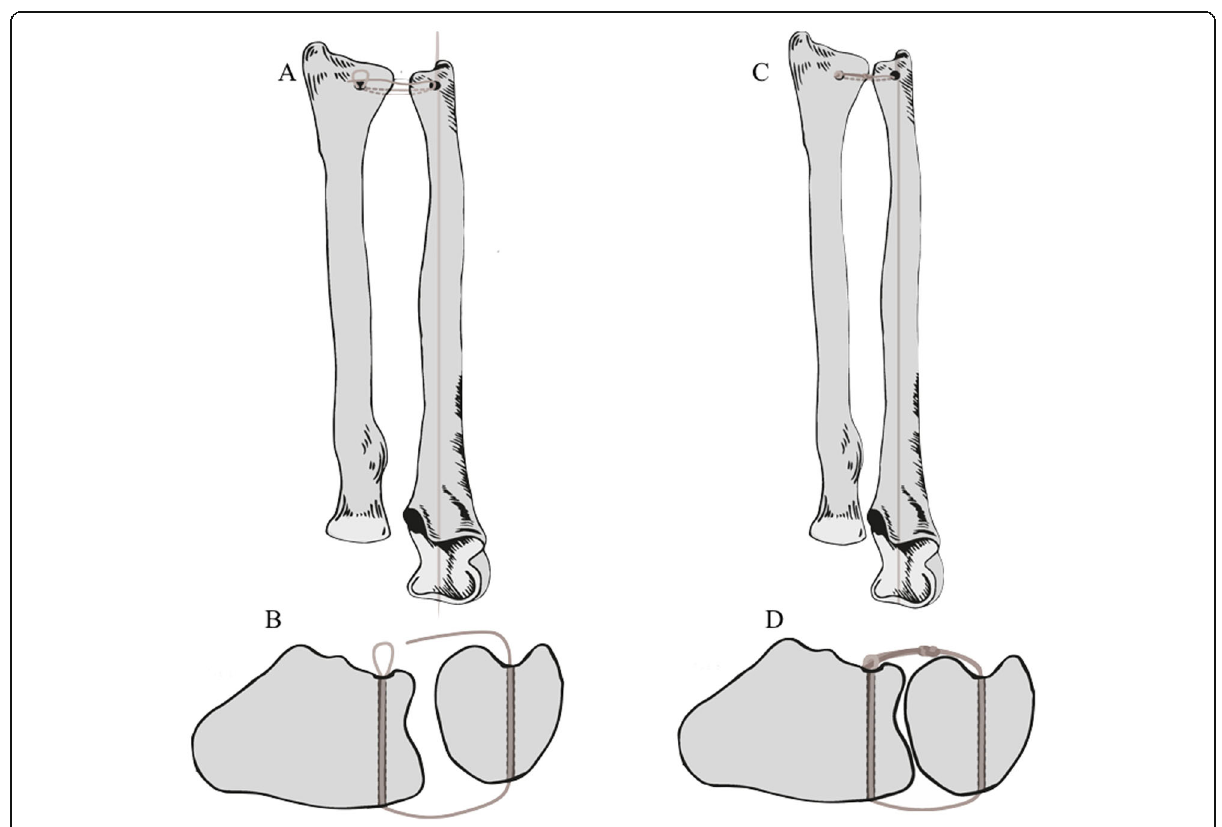
Fig. 4 Technique illustration depicting the distal ulnar joint before ( a and b ) and after ( c and d ) tendon graft tensioning. Observe joint congruency and stability in both sagittal and coronal planes